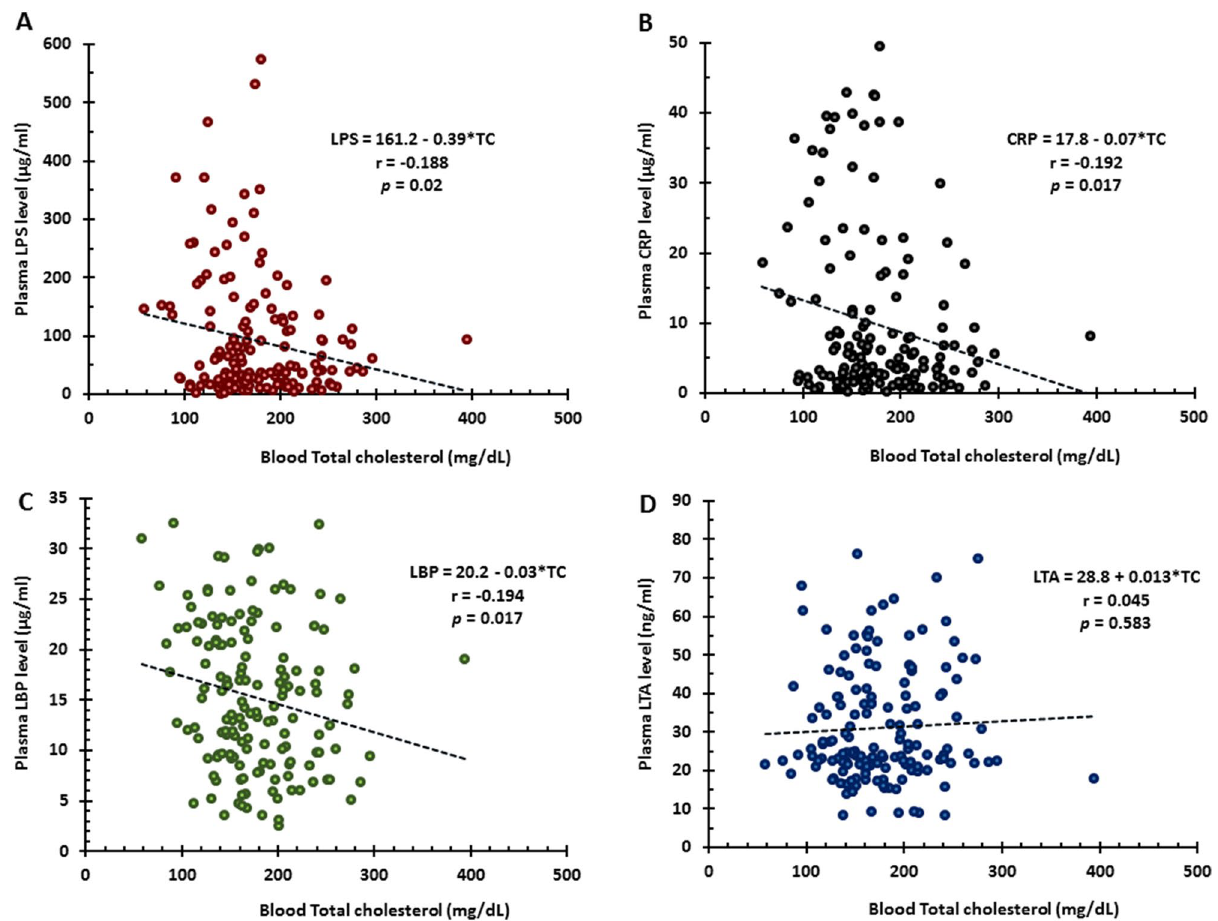
Figure 5. Pearson Correlation Analysis for total cholesterol and levels of LPS, LBP, CRP, and LTA. Total cholesterol negatively correlated with plasma LPS levels ( A ), CRP levels ( B ), LBP levels ( C ) but not with LTA levels ( D ). TC total cholesterol, LPS lipopolysaccharide, LBP lipopolysaccharide binding protein, CRP C-reactive protein, LTA lipoteichoic